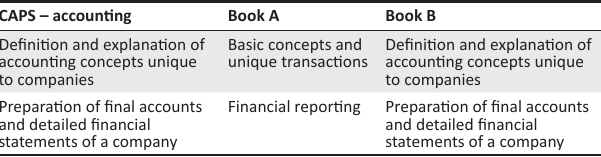
TABLE 2: Comparison of naming of